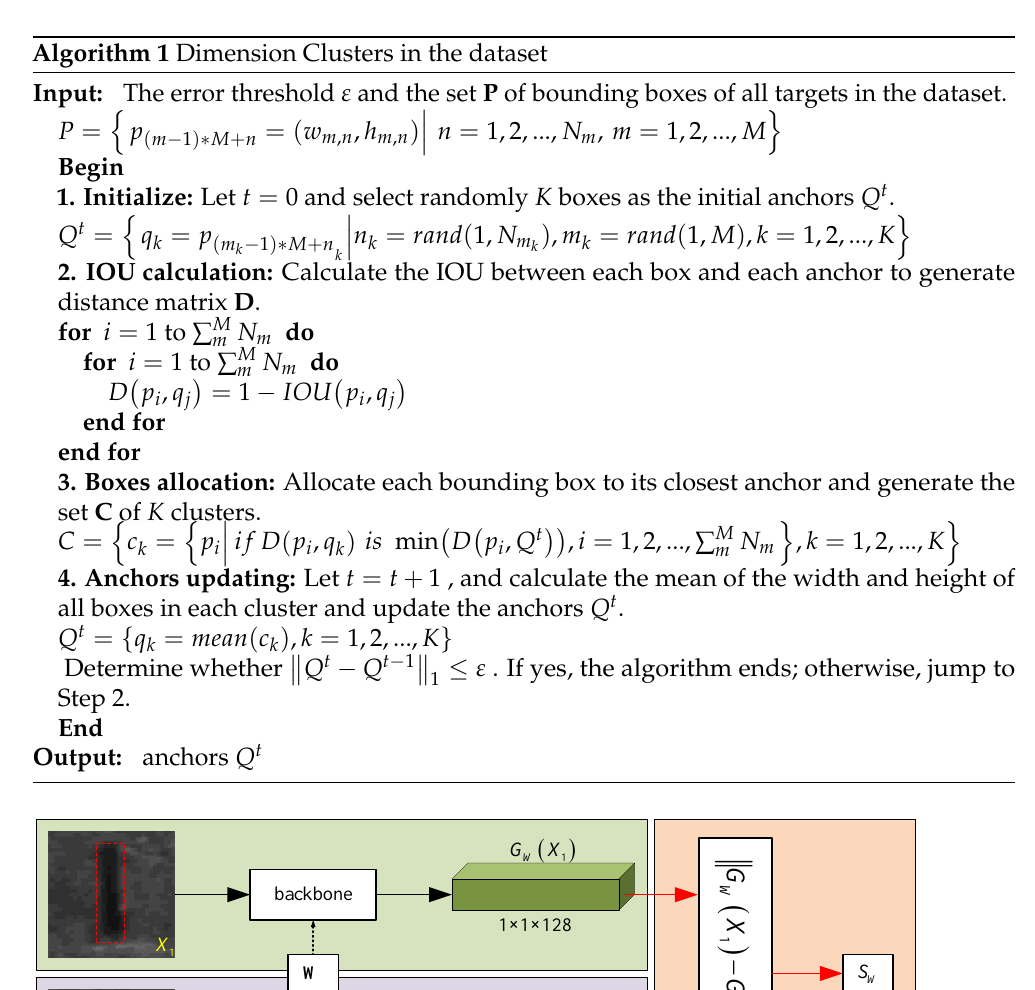
Algorithm 1 Dimension Clusters in the dataset